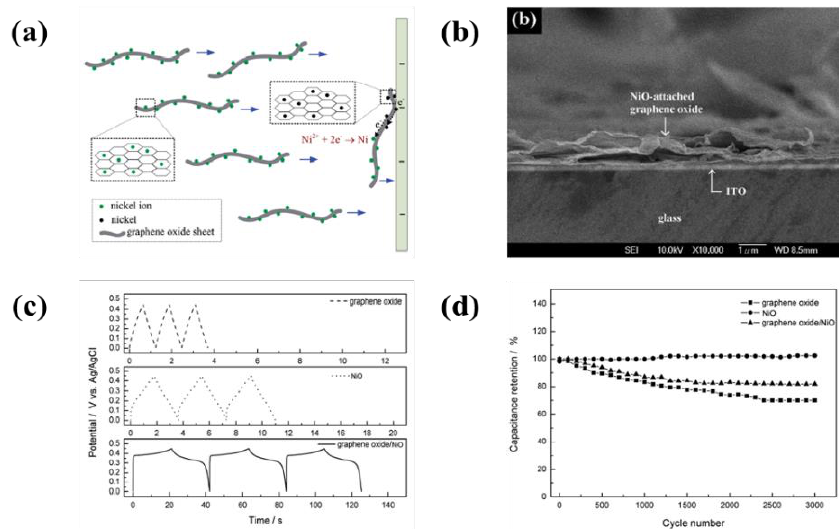
Figure 25. ( a ) Schematic formation of nickel-attached graphene oxide in the EPD process; ( b ) SEM image of NiO-attached graphene oxide hybrid electrode after heat treatment; ( c ) Galvanostatic charge/discharge curves of graphene oxide, NiO, and NiO-attached graphene oxide hybrid electrodes at a current density of 10 A · g − 1 in 0.5 M KOH electrolyte; ( d ) Relationship between the capacitance retention and the cycle number of graphene oxide, NiO, and NiO-attached graphene oxide hybrid electrodes at 10 A · g − 1 .